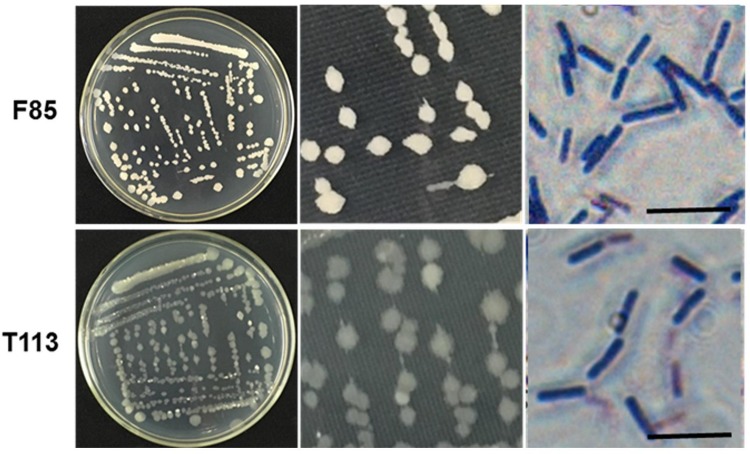
Colony morphology and gram staining of the F85 and T113. Both strains strained purpled, identifying them as Gram-positive bacteria. The cells were rod-shaped. The F85 colonies were khaki, the edges were clearcut, and the surface was dry and opaque. The colony of T113 had a dull color and a smooth, translucent surface.